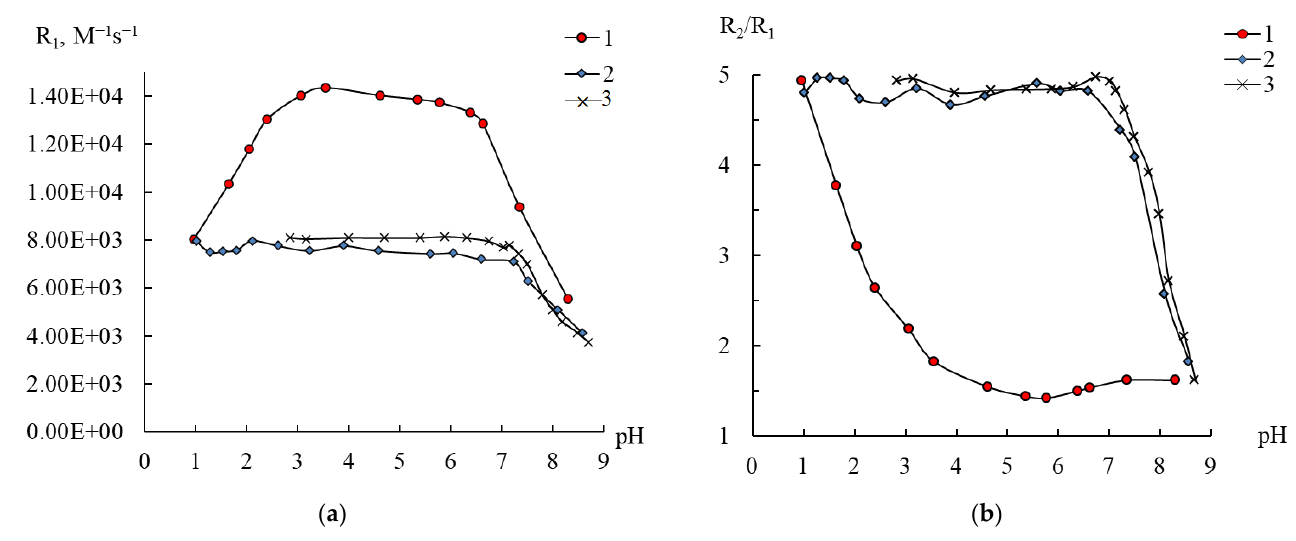
Figure 8. Changes in the relaxation efficiency R1 ( a ) and the R 2 /R 1 ratio ( b ) on pH 0.1 mM solutions of compound 3 in water (1) and in PEI solution (2), and Mn(II) ions in PEI solution (3). C Mn(II) 0.2 (1, 2), 0.4 mM (3), SPEI 10 mM (2, 3).